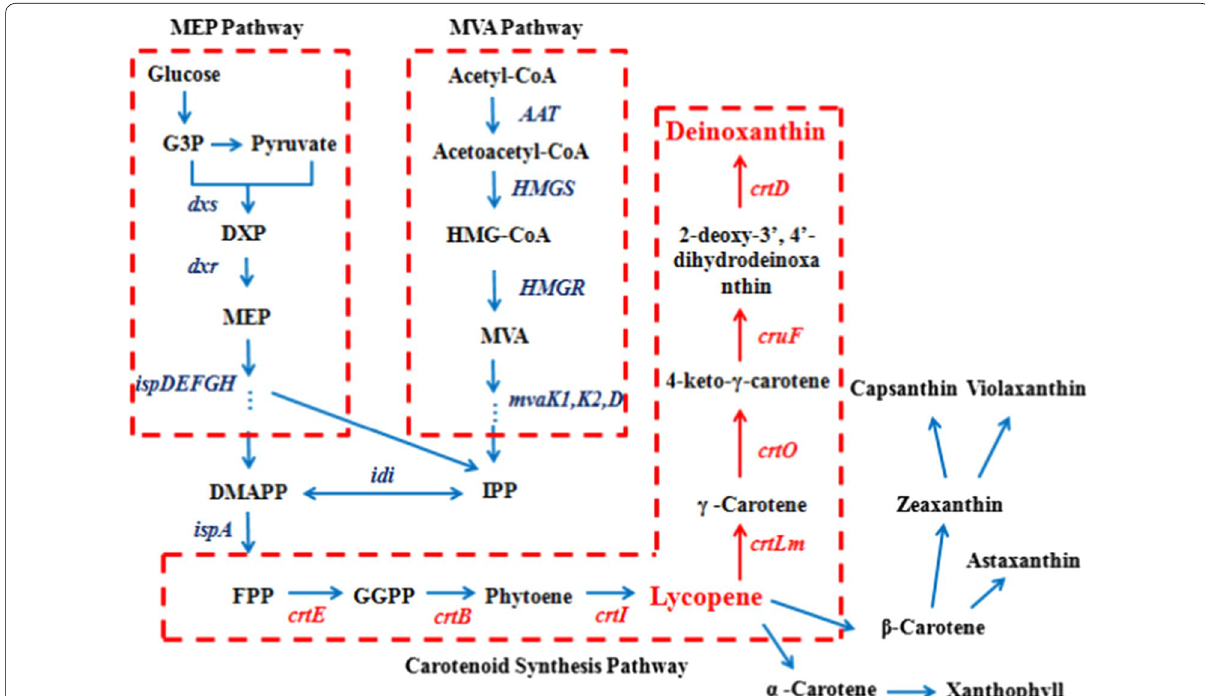
Fig. 1 The biosynthesis pathways of lycopene and other carotenoids. The MVA pathway is found in eukaryotic cells, the cytoplasm and mitochondria of plants. The MEP pathway is found in bacteria, other prokaryotes and plastids in plants. The carotenoid synthesis pathway in Deinococcus radiodurans R1 was marked with red arrows. G3P glyceraldehyde 3-phosphate, DXP 1-deoxy- d -xylulose-5-phosphate, MEP 2-C-methyl- d -erythritol-4-phosphate, DMAPP dimethylallyl diphosphate, IPP isopentenyl diphosphate, HMG-CoA 3-hydroxy-3-methyl glutaryl coenzyme A, MVA mevalonate, FPP farnesyl diphosphate, GGPP geranylgeranyl